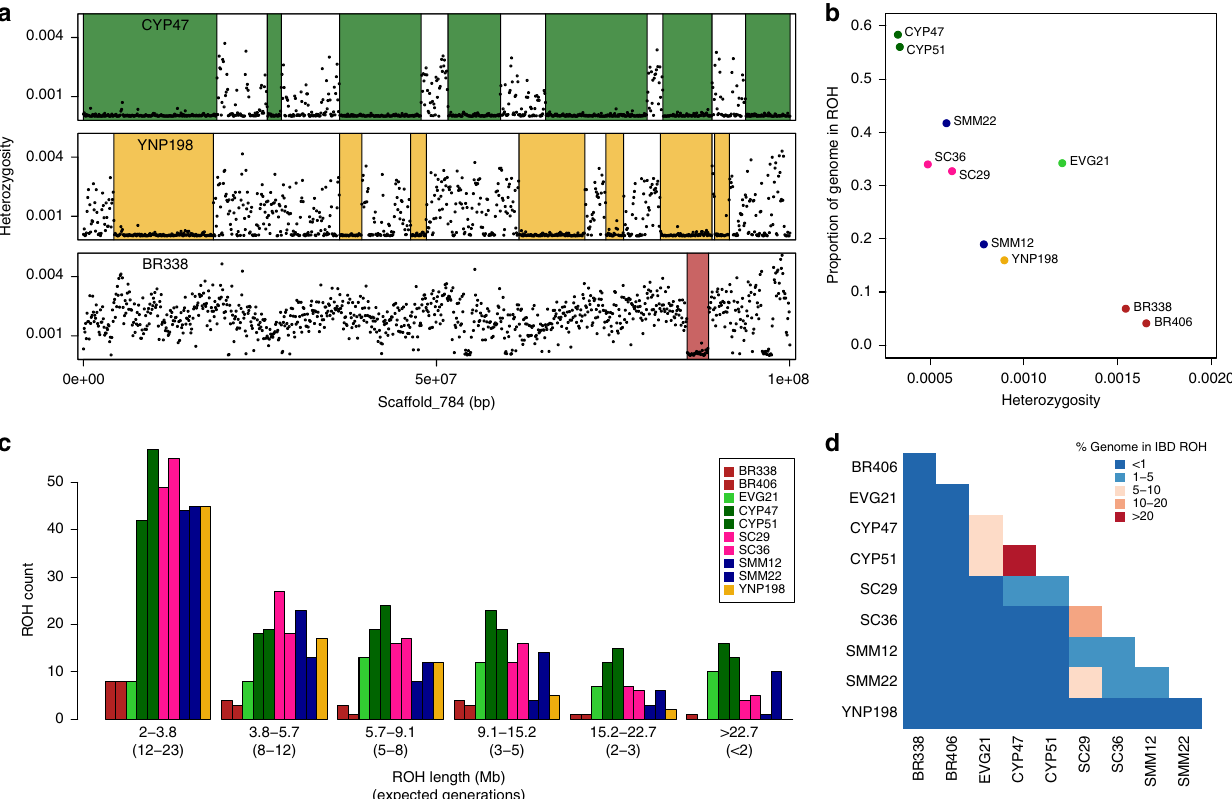
Fig. 4 Heterozygosity and runs of homozygosity. a Sliding window heterozygosity (black dots) and called ROH (colored boxes) across a single scaffold for three pumas from three different populations (Big Cypress, Yellowstone, and Brazil). Plots for all pumas are provided as Supplementary Fig. 12. b Average genome-wide heterozygosity versus the proportion of the genome in ROH for the ten pumas sequenced. c Distribution of lengths of ROH. The length in Mb is indicated, as is the associated expected number of generations since the individual ’ s maternal and paternal lineages shared a common ancestor. d Heat map showing the percent of the genomes that are in ROH that are shared IBD between pairs of pumas (Supplementary Table